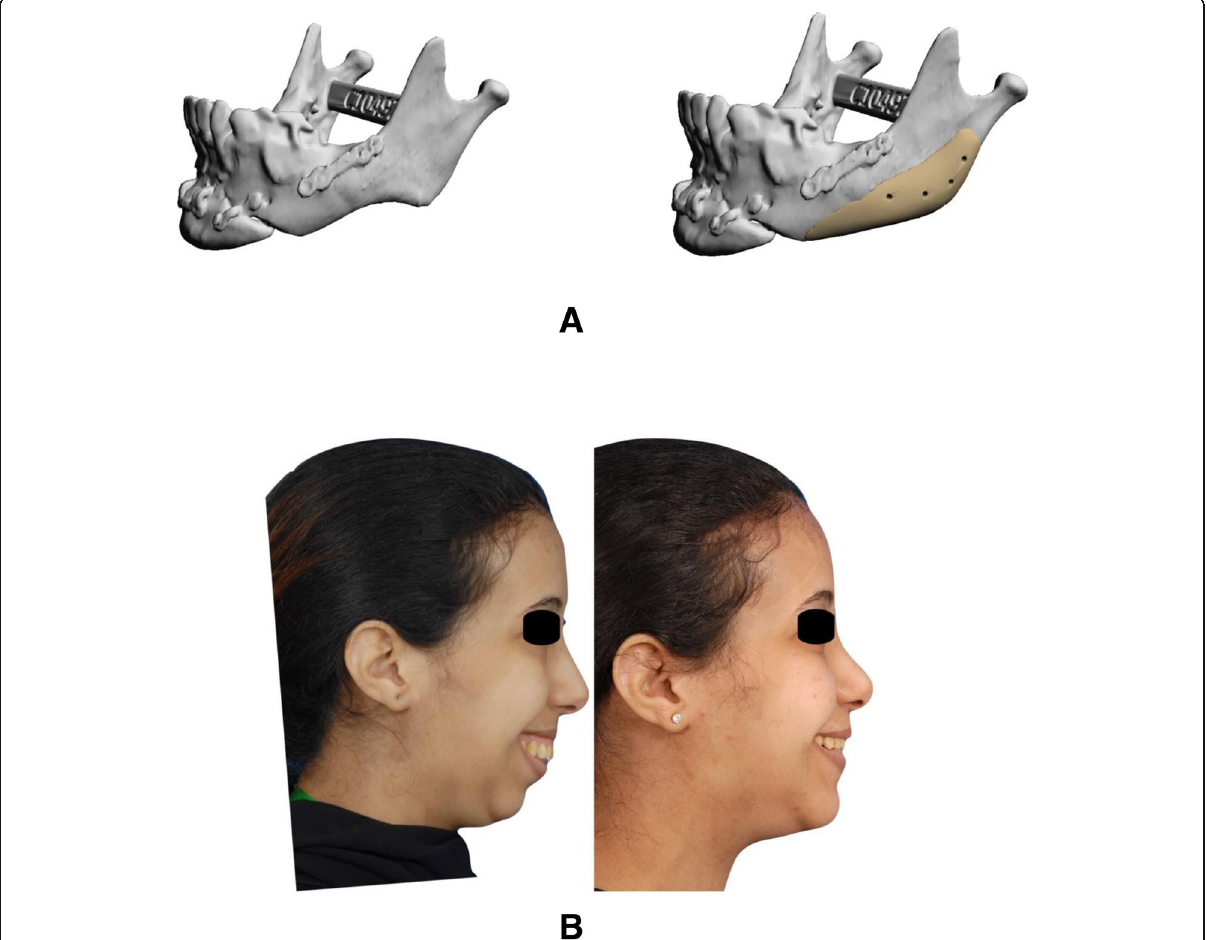
Fig. 3 Post-BSSO case. a 3D reconstruction of CT showing defect and planned implants. b Pre- and postoperative photographs of the